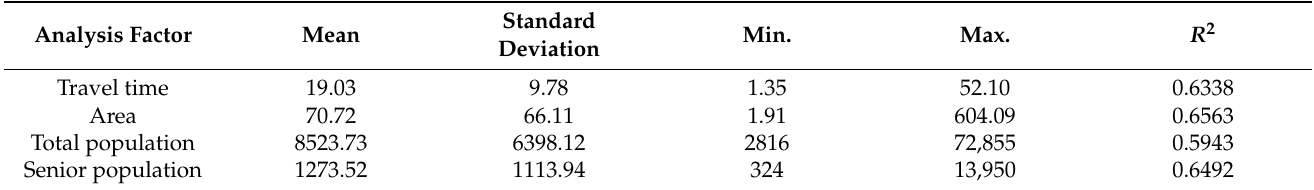
Table 6. The output of the clustering analysis based on the four different variables of travel duration, area of each sub-district, population within the area and number of senior